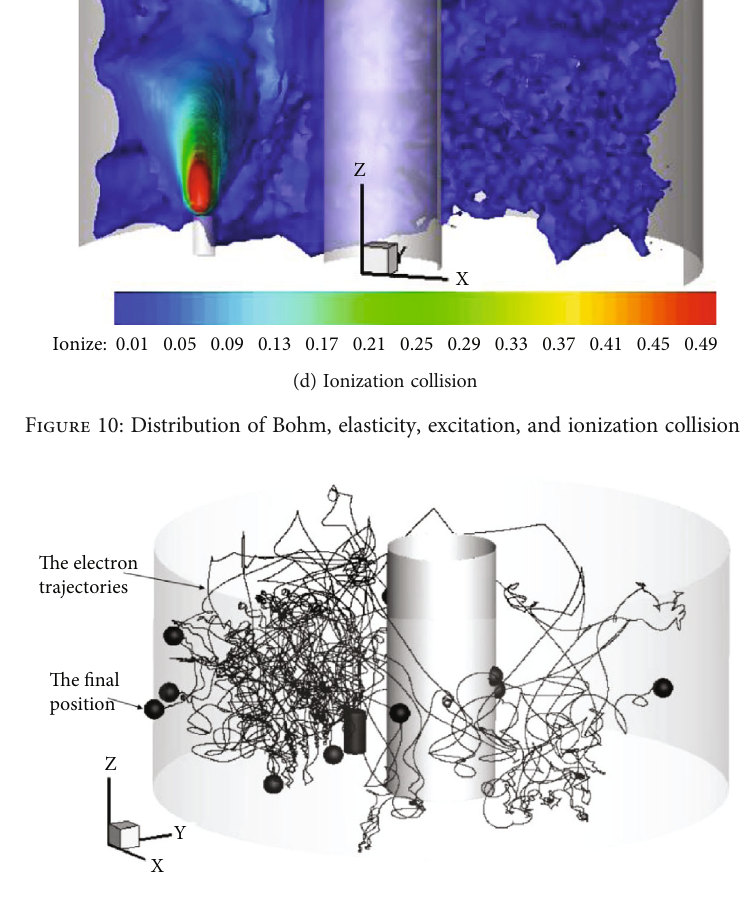
Figure 11: Primary electron